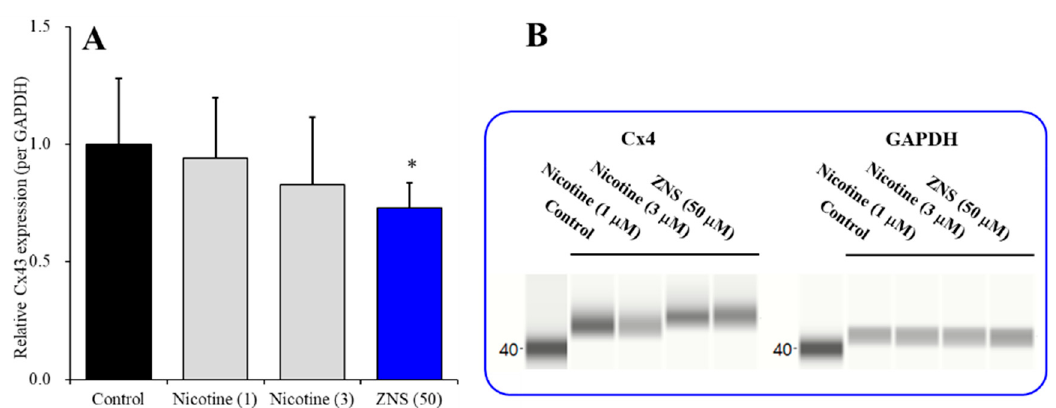
Figure 3. Concentration-dependent e ff ects of subchronic administration of nicotine (0, 1 and 3 µ M) and lowest therapeutic-relevant concentration of zonisamide (ZNS) (50 µ M) for 7 days on Cx43 expression in the plasma membrane fraction of primary cultured astrocytes from wild-type rat ( A ) and pseudo-gel images using Simple Western results using anti-GAPDH and anti-Cx43 antibody for blotting of plasma membrane fractions of wild-type ( B ). In panel 3A, ordinate: mean ± SD (n = 6) of relative protein level of Cx43. *: P < 0.05 relative to control by student T-test. Concentration-dependent e ff ects of nicotine on Cx43 expression was not detected by one-way ANOVA.